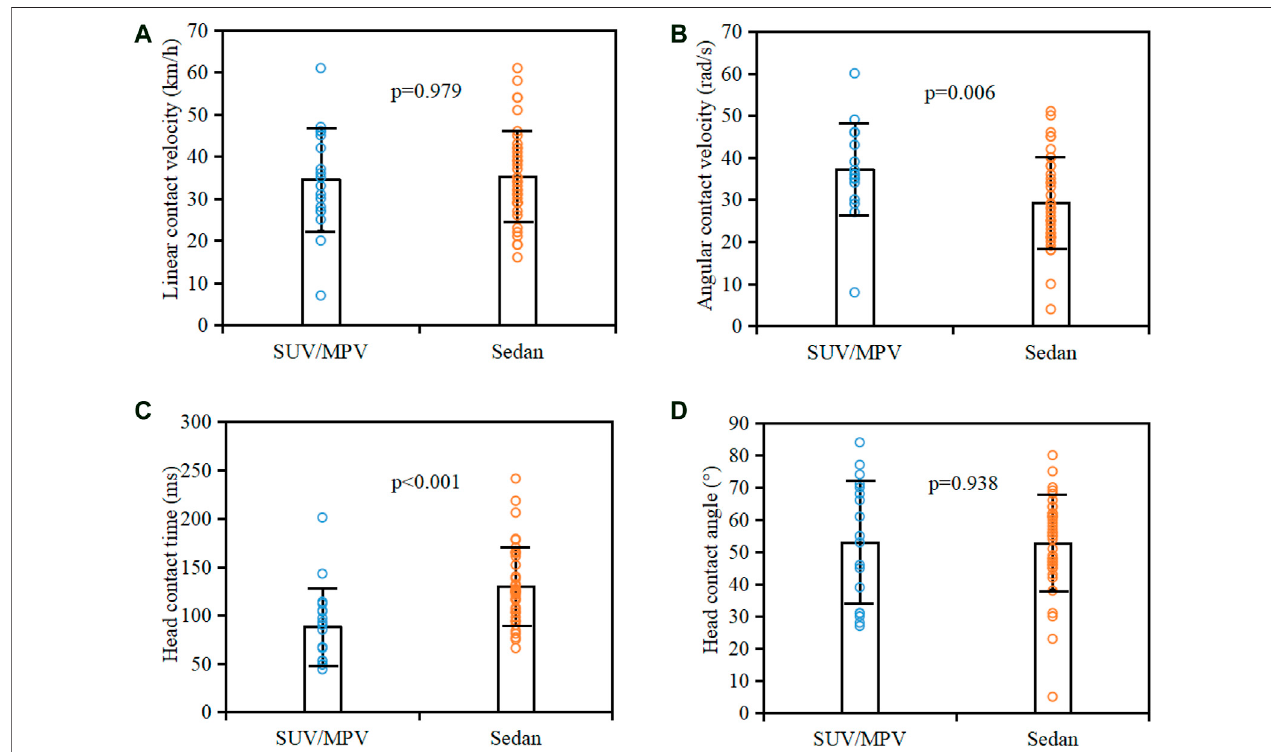
FIGURE 10 | Comparison of head linear contact velocity (A) , angular contact velocity (B) , contact time (C) , and contact angle (D) between sedan and SUV/MPV crashes.